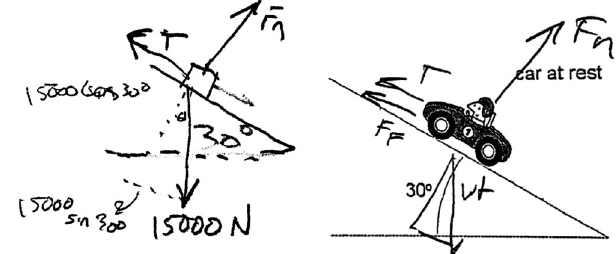
FIG. 3. An example of the different FBDs drawn for the tension problem (left) and the friction problem (right) by the same student. This student made two mistakes in the FBD for the frictional force: (i) An additional tension force was mistakenly included. (ii) The direction of the frictional force was incorrect.